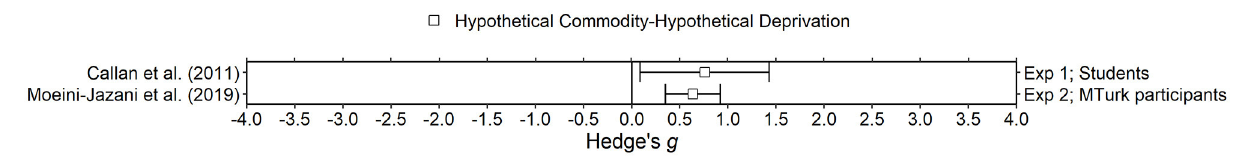
FIGURE 7 | Effect sizes for financial deprivation experiments. Effect size is Hedge’s g . Points closer to 0 indicate smaller effect sizes. Points to the right of the line indicate increases in delay discounting due to deprivation, the predicted effect. Subjects discounted hypothetical outcomes and experienced hypothetical deprivation.